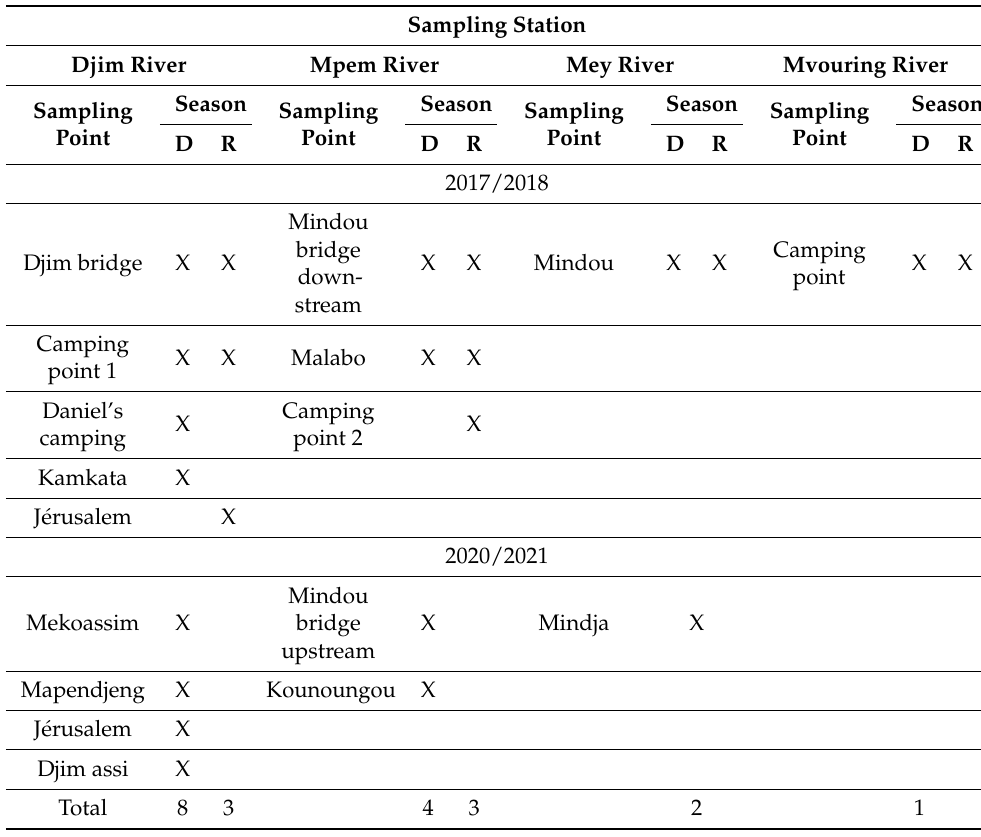
Table 1. Sampling stations and frequencies or seasons (D = dry season; R = rainy season). Sampled (X) or not sampled